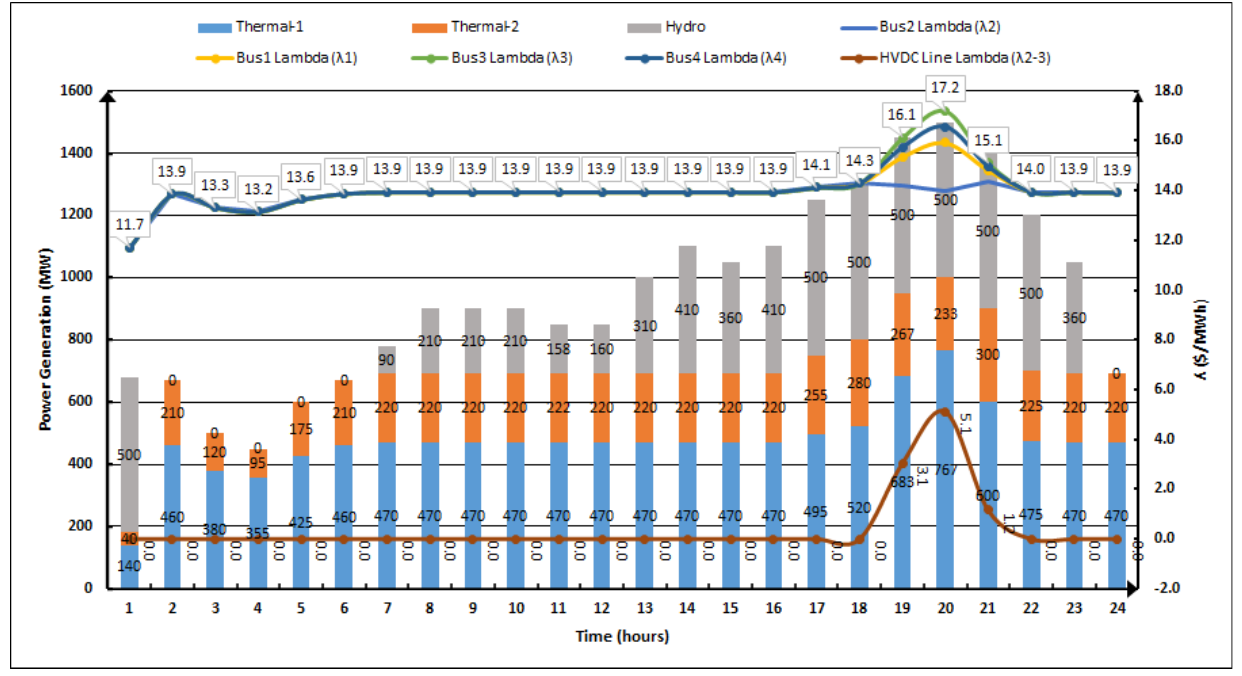
14 of 20 Figure 5. Load pa (cid:308) ern on network.